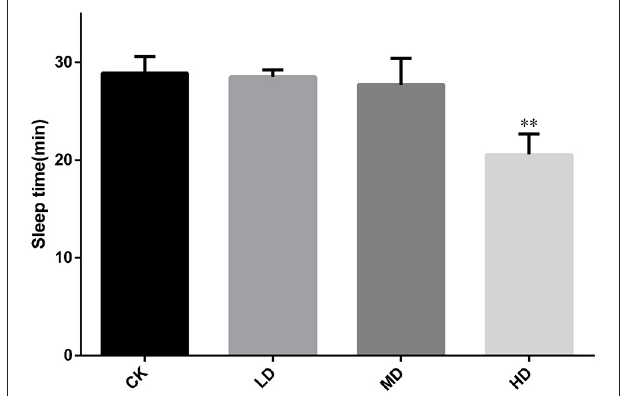
FIGURE 1 | Effect of GRAE on the sleep time of mice induced by pentobarbital sodium in sleep improvement experiment. Each bar represents the mean ± SD ( n = 10). * P < 0.05 vs. control group, ** P < 0.01 vs. control group.